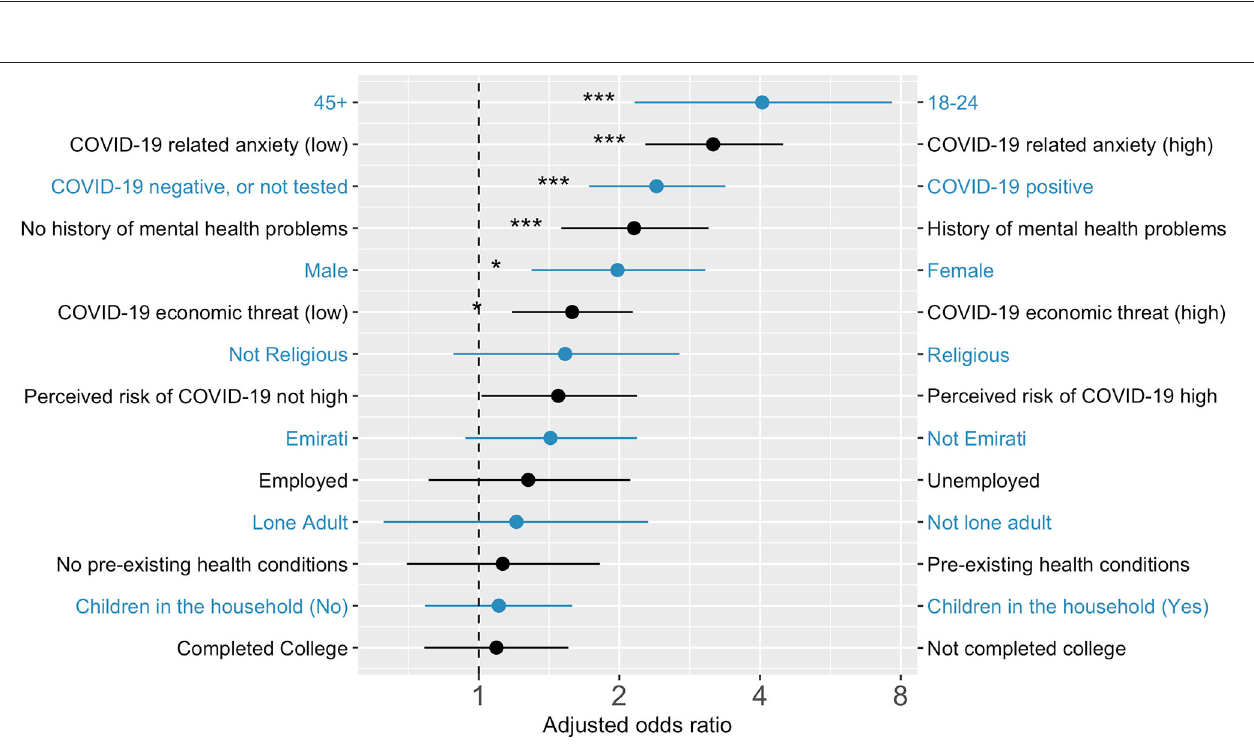
FIGURE 2 | Adjusted odd ratios from a logistic regression predicting GAD7 anxiety symptom scores. Note: 18–24 years age group had significantly higher odds of depression and anxiety when compared to all other ag groups. Figure built using https://github.com/SourCherries/odds-forest. * p < 0.05, *** p < 0.001.